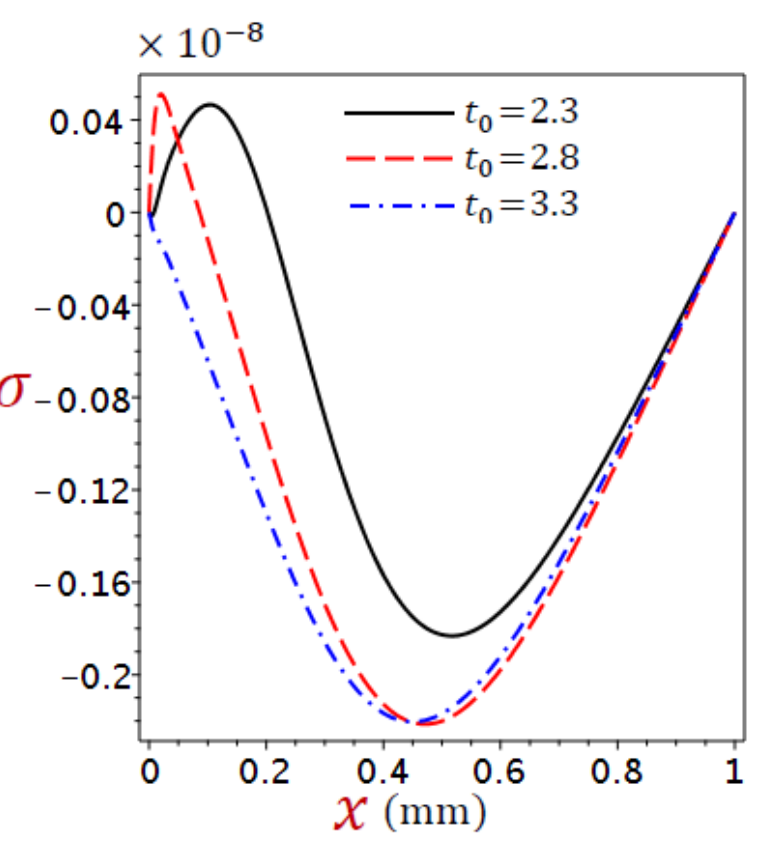
Figure 9. Variations of stress ( σ ) across the skin tissue using numerous values of the ramp-time parameter for the refined DPL model.